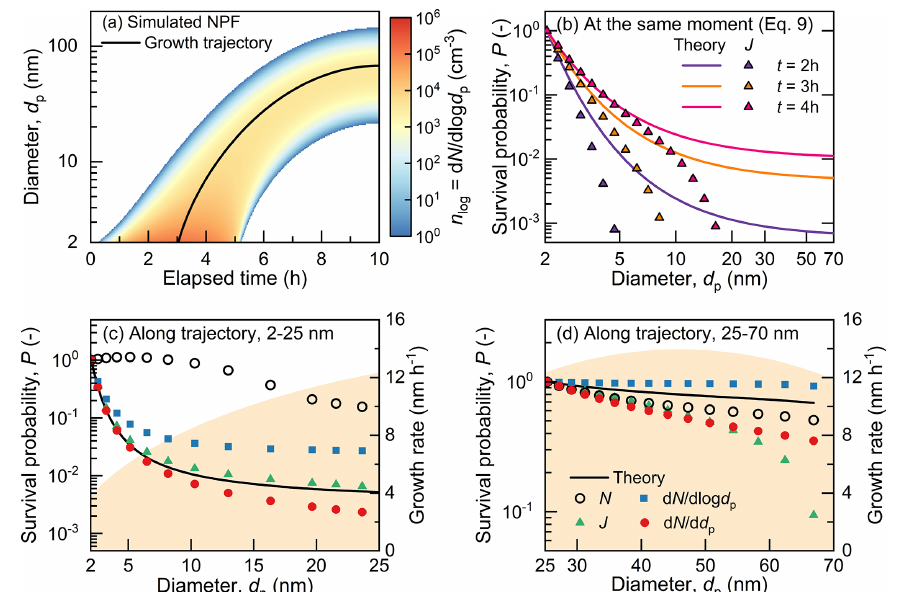
Figure 4. Survival probabilities of new particles in an NPF event with varying formation and growth rates. (a) Simulated evolution of size distribution of new particles. (b) The survival probabilities of new particles retrieved using Eq. (10) for steady-state size distributions at 2, 3, and 4h elapsed time ( t ). Theoretical survival probabilities evaluated at the corresponding time are also shown. (c) The survival probability of 2–25nm particles following the growth trajectory. N is the total number of particles. (d) The survival probability of 25–70nm particles following the growth trajectory. The growth rate is time- and size-dependent for this simulation. Panels (c) and (d) show the growth rate along the growth